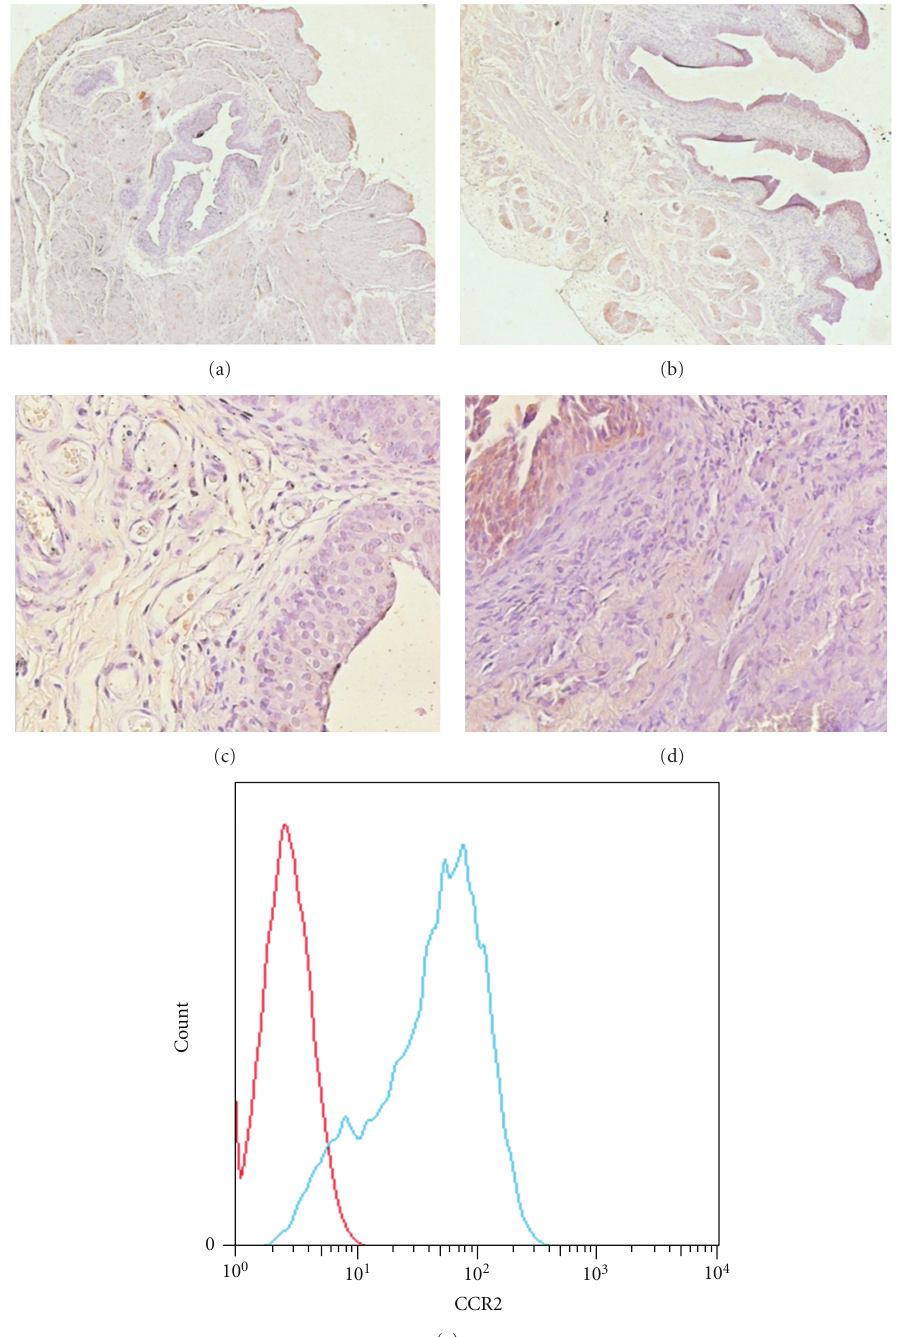
Figure 4: LPS-induced CCR2 receptor expression in bladder tissues. (a) and (c) Control group; (b) and (d) LPS group. CCR2 receptors were detected with immunohistochemistry ((a) and (b) × 40; (c) and (d) × 400). (e) LPS-increased CCR2 receptor expression on the surface of mast cells detected by flow